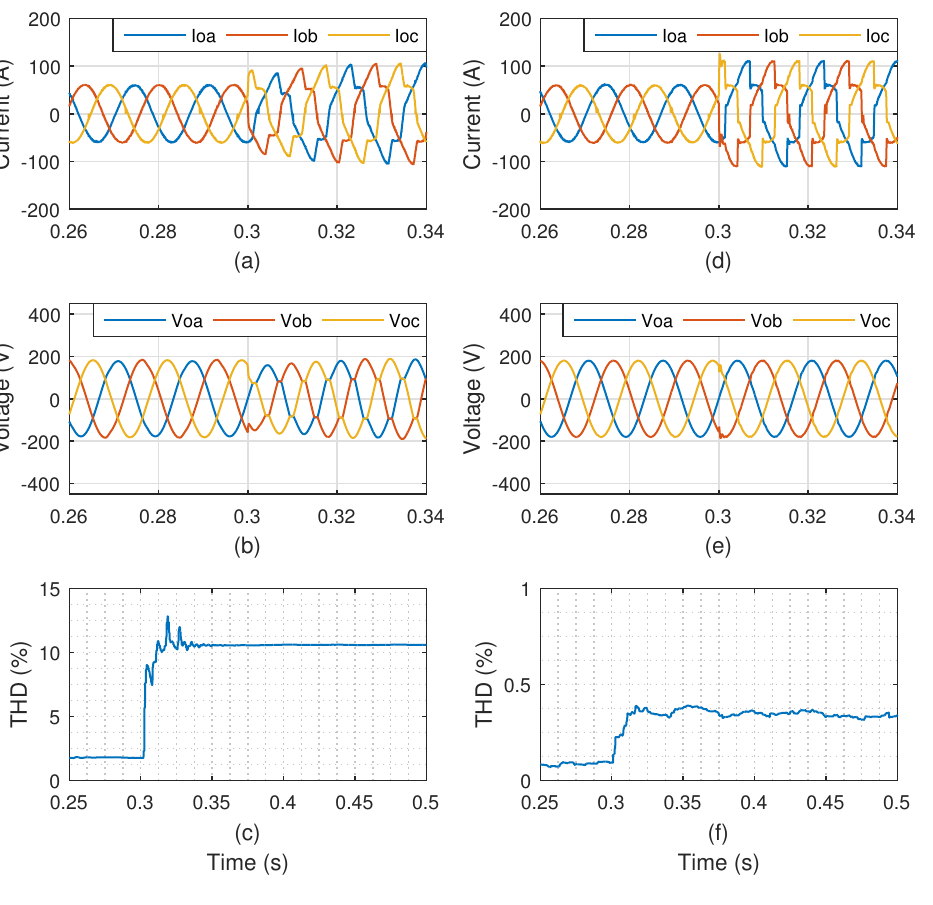
Figure 12. AC-AC 3 × 3 DMC operating with PI 1 ( s ) and no feedforward. ( a ) Output current, ( b ) output voltage, and ( c ) Total Harmonic Distortion (THD) of the output voltage. AC-AC 3 × 3 DMC operating with PI 4 ( s ) and no feedforward. ( d ) Output current, ( e ) output voltage, and ( f ) THD of the output